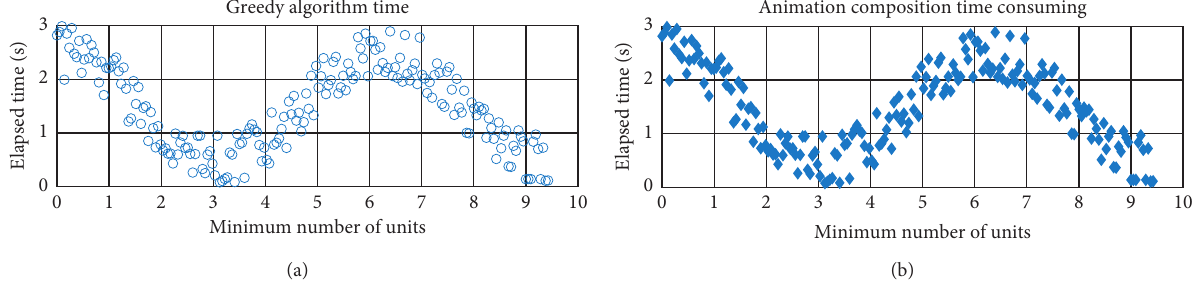
Figure 8: Greedy algorithm’s fast adaptive character animation synthesis time. (a) Greedy algorithm time. (b) Animation composition time